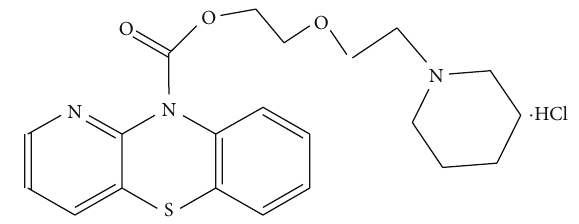
Figure 1: The chemical structure of pipazethate HCl (PZT).